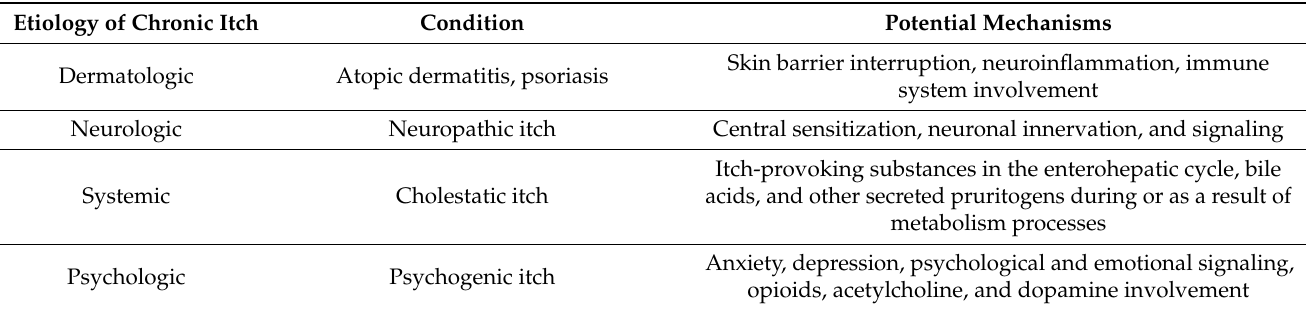
Table 1. Various itch etiologies and examples of potential